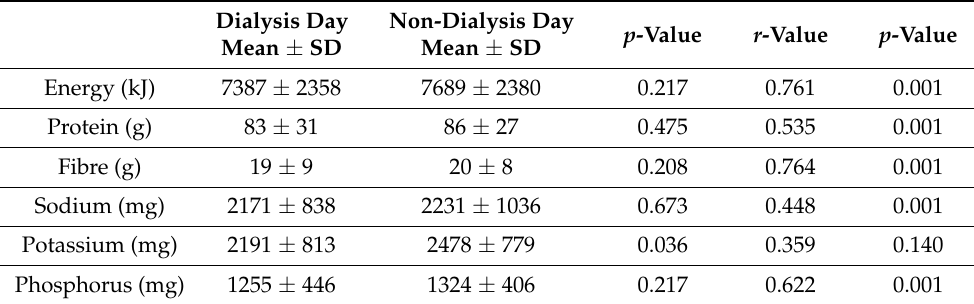
Table 5. Descriptive statistics of dietary intake of dialysis and non-dialysis days according to 24 hr multi pass recall ( n = 46, those on PD not included n =